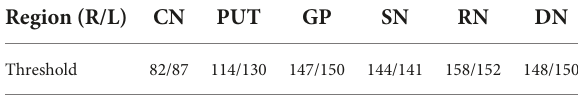
TABLE 1 The MSV threshold of gray matter nuclei in brain (from CS). Region